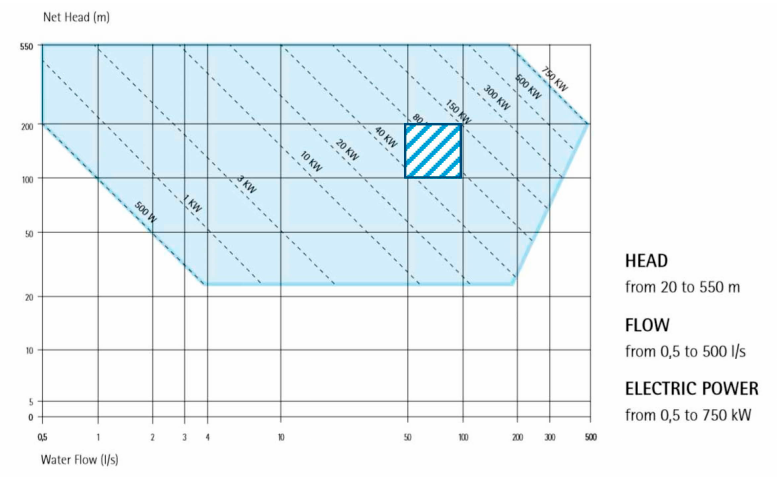
Figure 5. Developing net power for the chosen Pelton turbine. The hatched rectangle represents the expected working